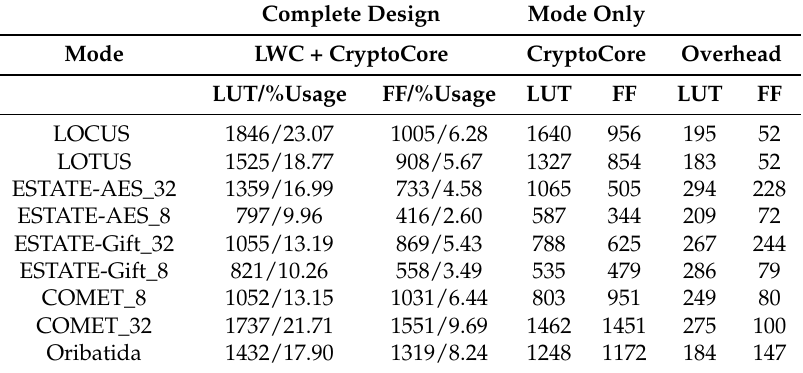
Table 3. Overhead in resources for complete design (LWC + CryptoCore) compared with CryptoCore alone. %Usage is the percentage of utilization of available resources on the xc7a12tcsg325-3